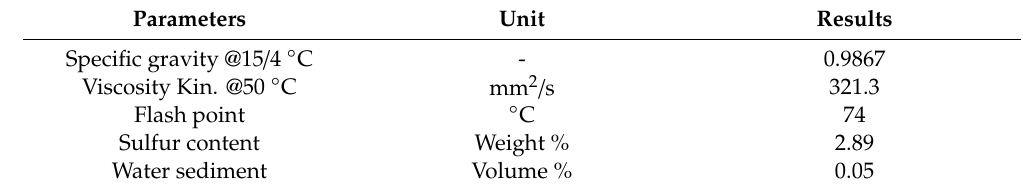
Table 2. Engine specifications.